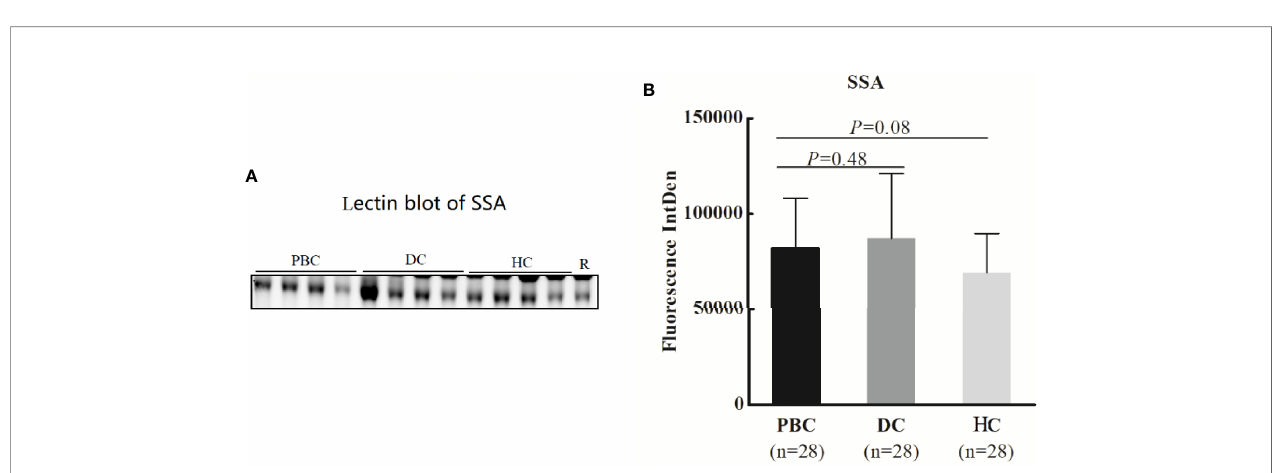
FIGURE 3 | Lectin blot of SSA lectin for serum IgG in PBC, DC and, HC groups. (A) Lectin blot of SSA for serum IgG from three groups, 12 PBC patients, 12 DCs ( fi ve AIH, seven PSS), and 12 HCs was selected from lectin microarray cohort, 16 PBC patients,16 DCs (four AIH, twelve PSS), and 16 HCs were selected from a new cohort. (B) Comparison of fl uorescence intensity of lectin blot bands in PBC, DC, and HC groups. PBC, primary biliary cholangitis; DC, disease control; HC, healthy controls; SSA, Salvia sclarea ; R, reference.